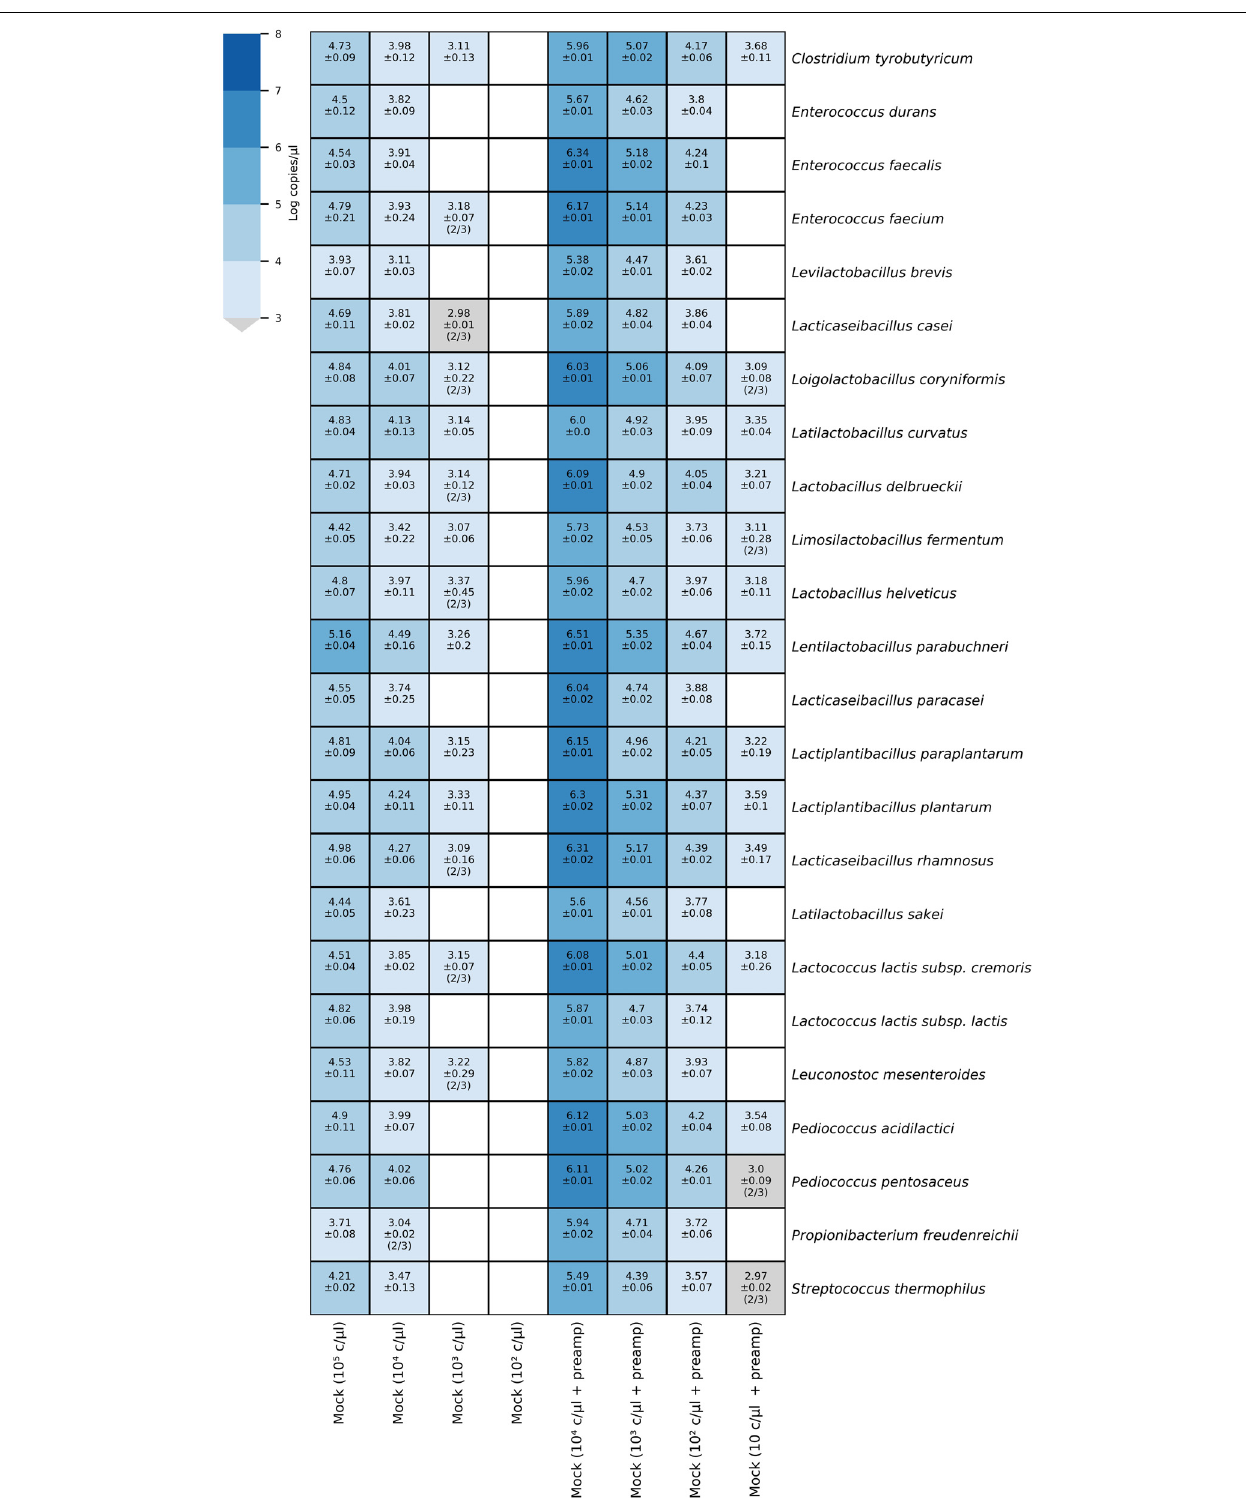
Frontiers in Microbiology |